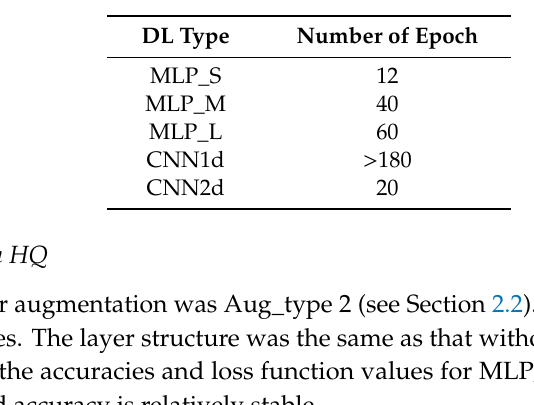
Table 7. Epoch number required for loss function to be less than 0.5.